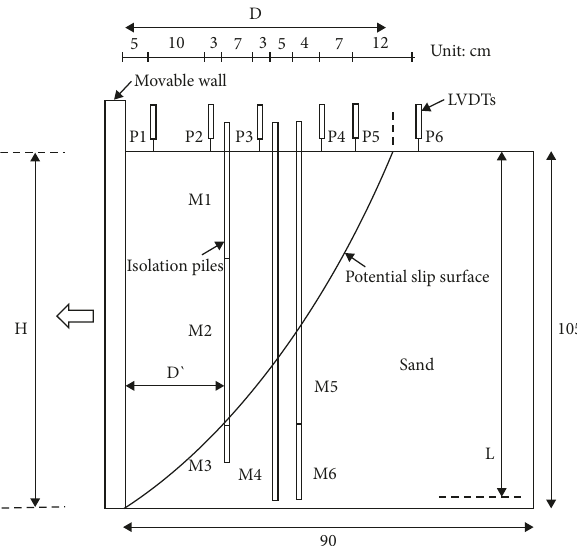
Figure 3: The summary of the physical model test and numerical simulation